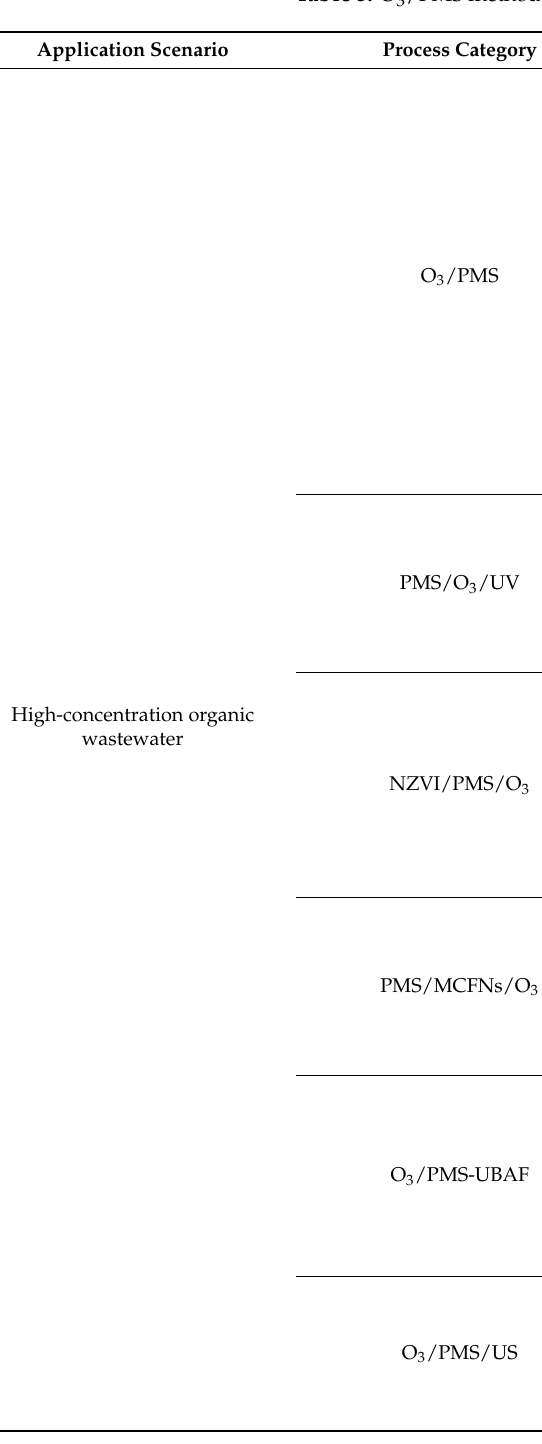
Table 5. O 3 /PMS method applications in organic degradation in highly concentrated organic